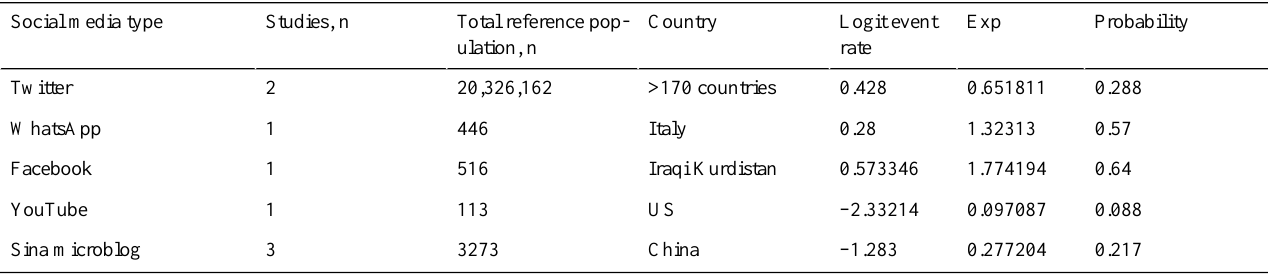
Table 4. Probability of fear effect for each social